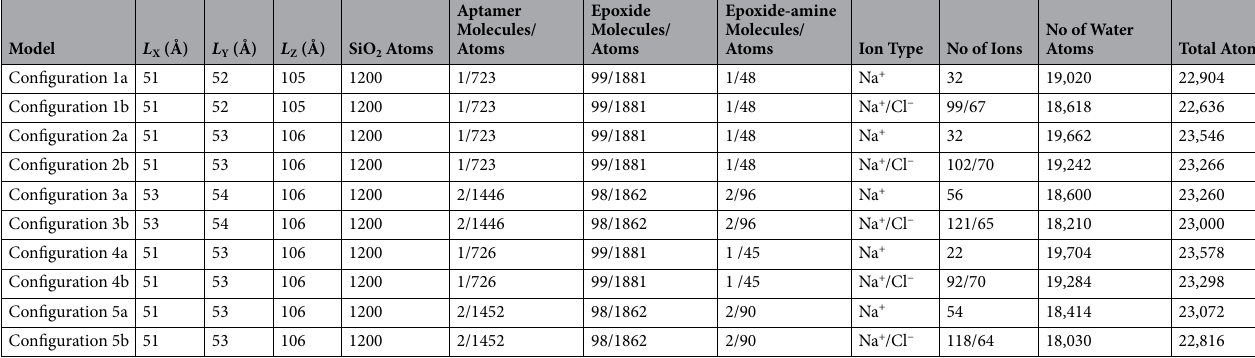
Table 2. Dimensions of the simulation box, number of atoms of the SiO 2 substrate, number of aptamer molecules and atoms, number of epoxide molecules and atoms, number of epoxide-amine linkers and atoms, ion type and number of ions in the system, number of water atoms, and total number of atoms for each of the 10 different molecular dynamics simulations.